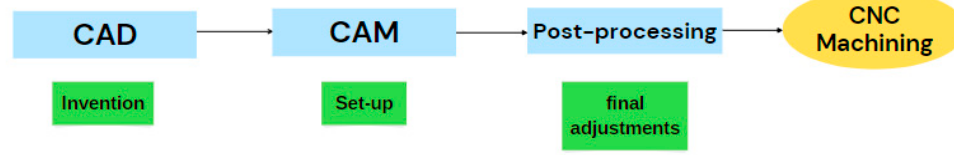
Figure 6. Representation of the CAM-CAD process on a CNC machine.